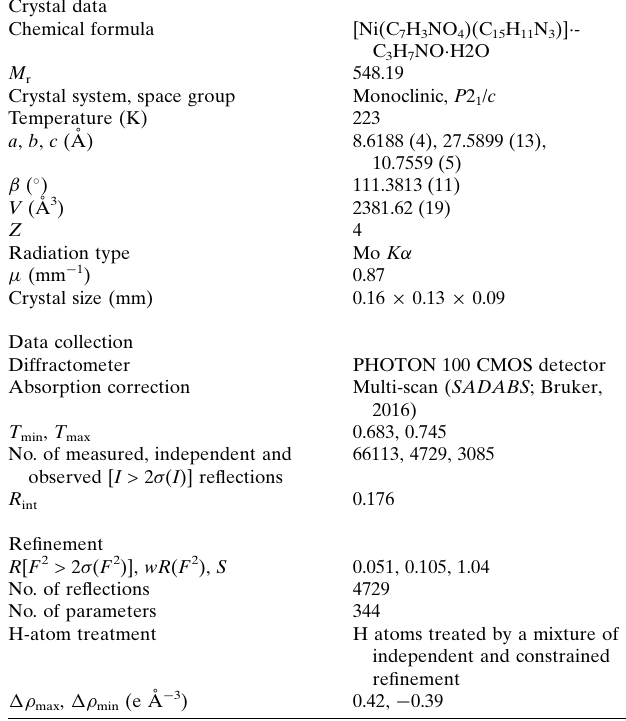
Table 2 Experimental details. Crystal data Chemical formula